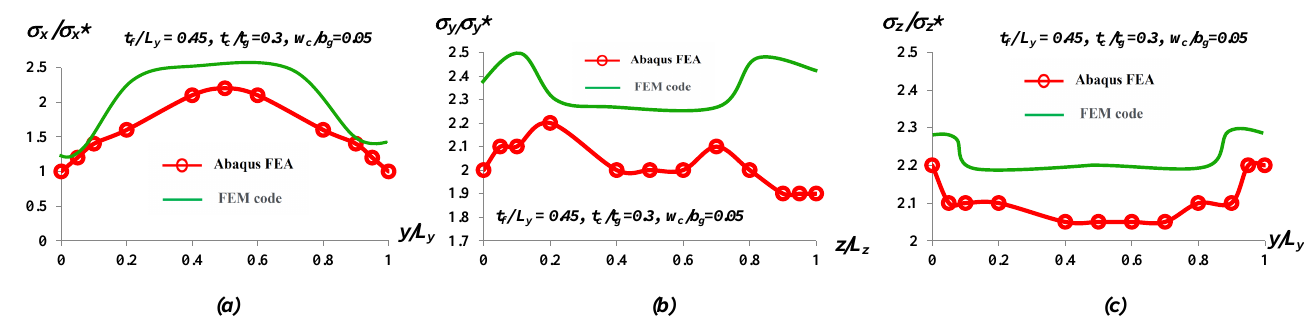
Figure 5. Distribution and comparison of different parts of stress fields between the numerical results of Abaqus FEA and FE model for ( a ) σ x / σ ∗ along y at z = L z /2 for applied traction t x ; ( b ) σ y / σ ∗ along x at y = L y /2 for applied traction t y ; ( c ) σ z / σ ∗ along y at z = L z /2 for applied traction t z MPa at the tip of the blade(i.e., x = L x ) for t f / L y = 0.45, t c / t g = 0.3, and w c / b g =